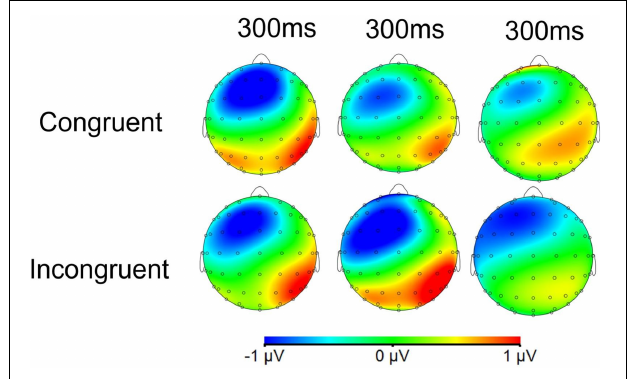
FIGURE 9 | Topographic maps of the voltage differences in the grand-average ERP N2 component (250–350 ms) among the odor conditions. The three columns from left to right are unpleasant odor, pleasant odor and no odor conditions,